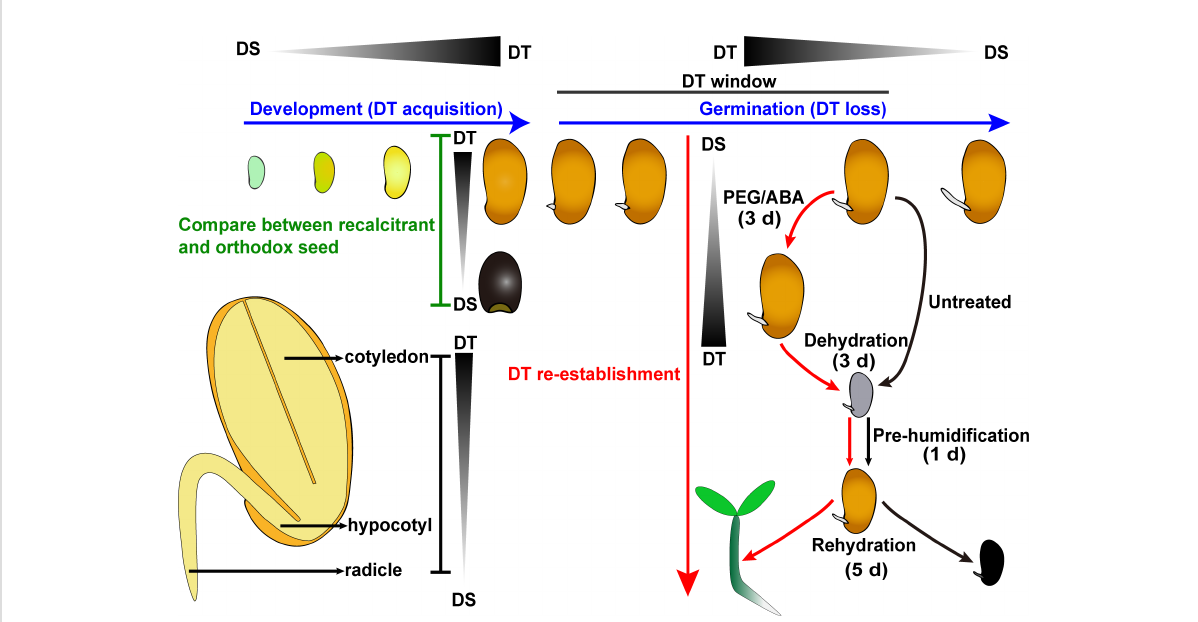
FIGURE 1 Schematic summary of the strategies used within DT studies in seed. Comparative analysis between orthodox and recalcitrant seeds is a handy strategy for depicting the character of DT (green words). Moreover, DT acquisition and loss accompanies the physiological processes of seed development and germination, respectively (blue words). When germinating seeds at the stage of radicle protrusion are fast dried (black arrows, 3 d), they do not survive, as shown by the lack of seedling growth after pre-humidi fi cation and rehydration. If drying treatment is preceded by PEG/ABA treatment (red arrows), after pre-humidi fi cation, seeds survive, as shown by further growth and seedling establishment. Emphasizing a PEG/ABA treatment can re-establish tolerance against desiccation treatment (red words). The detailed process of DT re-establishment of C. korshinskii seed is as follows: Seeds are germinated for 12 h, and then dried either directly or after 3 d of incubation in PEG 6000 solution of – 1.7 Mpa at 10°C. After incubation, germinating seeds are rinsed thoroughly in distilled water and then dehydrated in silica gel for 3 d, pre- humidi fi ed for 1 d, and imbibed for 5 d. The total duration of the experiment is about 2 weeks. After PEG treatment, 81% of radicles recovered DT, which means that C. korshinskii seed radicle successfully re-establish DT (Peng et al., 2017). In addition, the radicles appear to be the most desiccation-sensitive part of germinating seeds, followed by the hypocotyls and cotyledons (the lower left part). A triangle with a gradient of black and grey indicates the DT transition. DT, desiccation tolerance; DS,